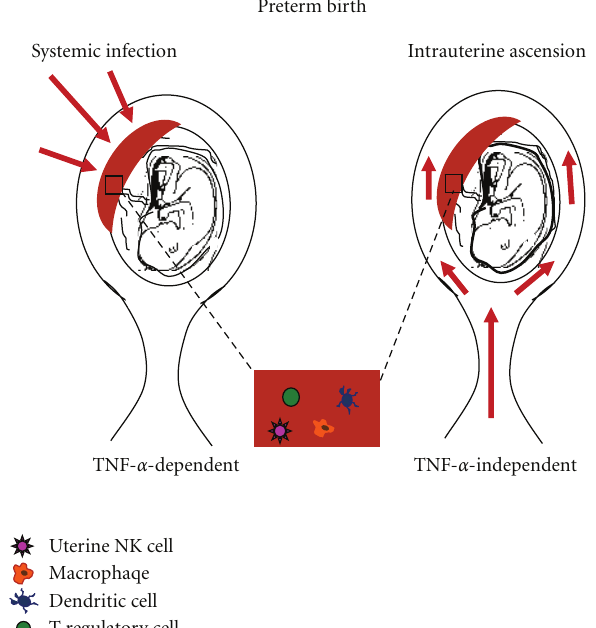
Figure 1: Roads to Preterm . Birth pathogens may enter the placental blood supply via systemic circulation due to previous or current onset of infection. Murine models where intraperitoneal injections are employed are utilized to mimic maternal systemic infection in order to study the ability of a pathogen to activate decidual immunity. Data presented in this paper demonstrate that systemic infections correlate to TNF- α -dependent immune responses that ultimately induce preterm birth. In contrast, intrauterine ascending infections occur when a pathogen ascends the uterine cavity via the vaginal tract. Surgical procedures in mice, rats, and rabbits have mimicked uterine cavity infections through intrauterine infusion of pathogens directly into the amniotic sac or between two placental units. Importantly, data summarized here demonstrate that pathogens introduced through intrauterine ascension do not tend to activate a TNF- α -driven axis to induce preterm